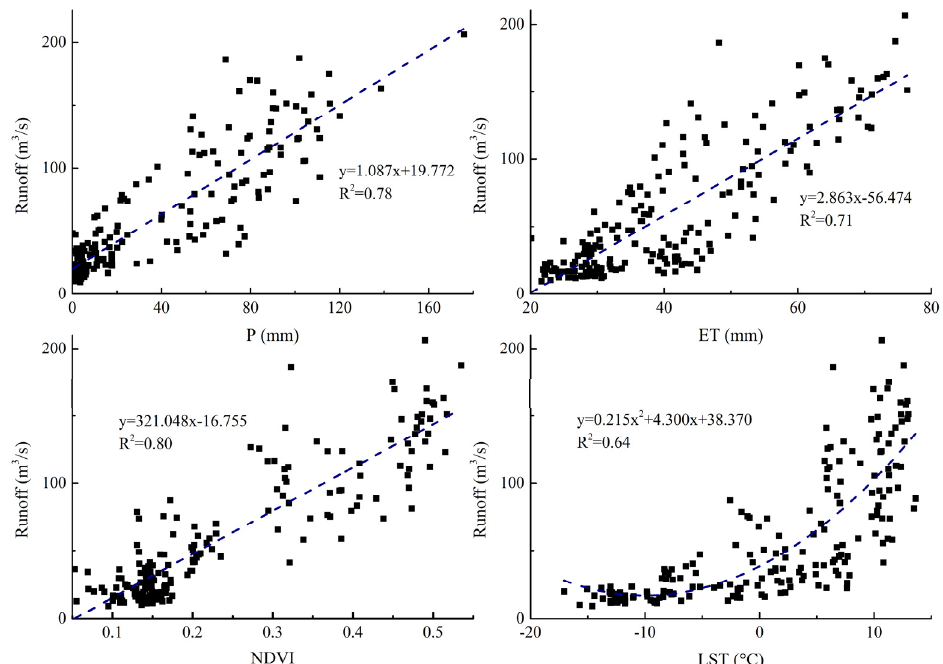
Figure 5. Scatter plots of the monthly P(RS), ET, NDVI, LST, and runoff. The blue dotted lines indi- cate the linear regression trendlines for the four factors and runoff.